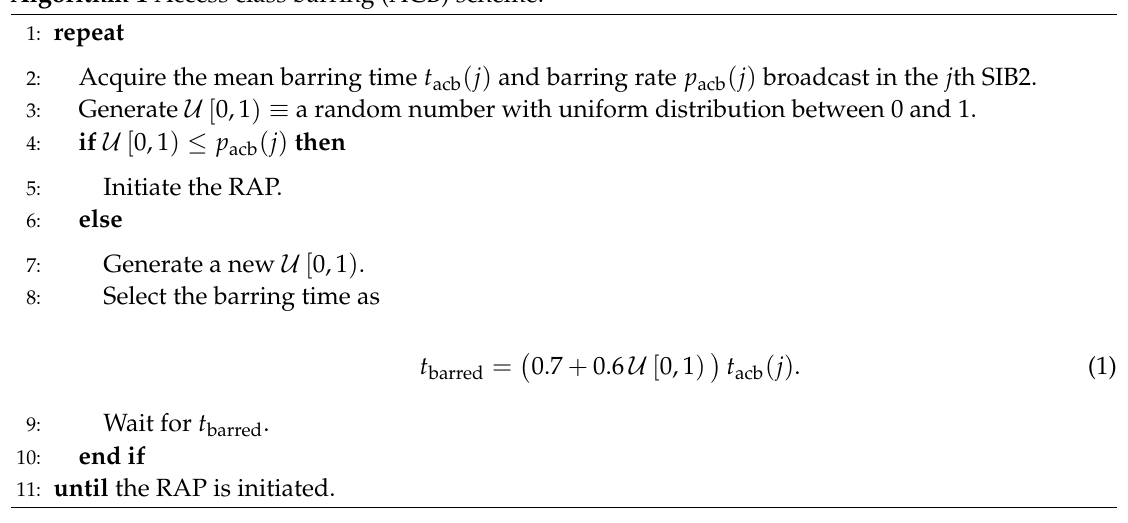
Algorithm 1 Access class barring (ACB)